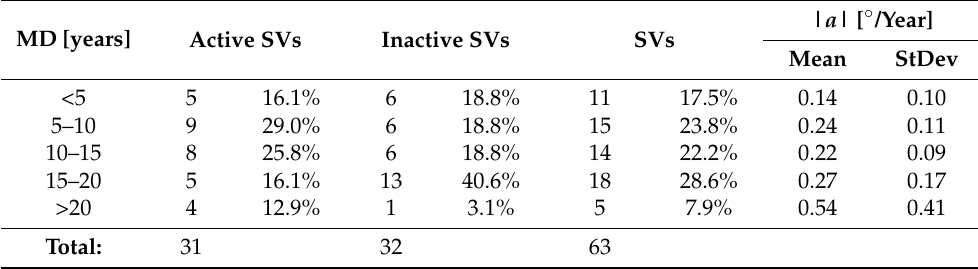
Table 4. Mission duration (MD) and absolute value of the separation trend.